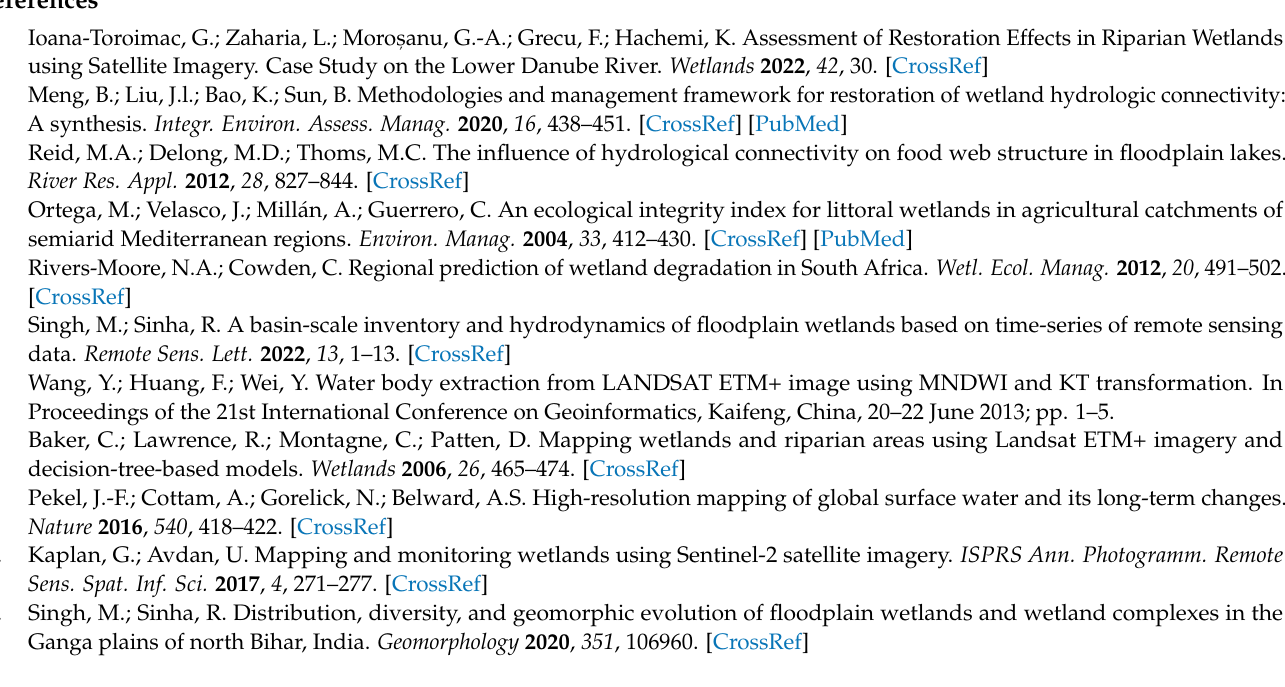
Table S4: Restoration priority distribution (in order of priority) for wetlands in Pilibhit, Udham Singh Nagar, Hardoi, Farrukhabad, Bijnor, and Amroha districts in Ramganga basin, Table S5: Monitoring priority distribution (in order of priority) for wetlands in Pilibhit, Udham Singh Nagar, Hardoi, Farrukhabad, Bijnor, and Amroha districts in Ramganga